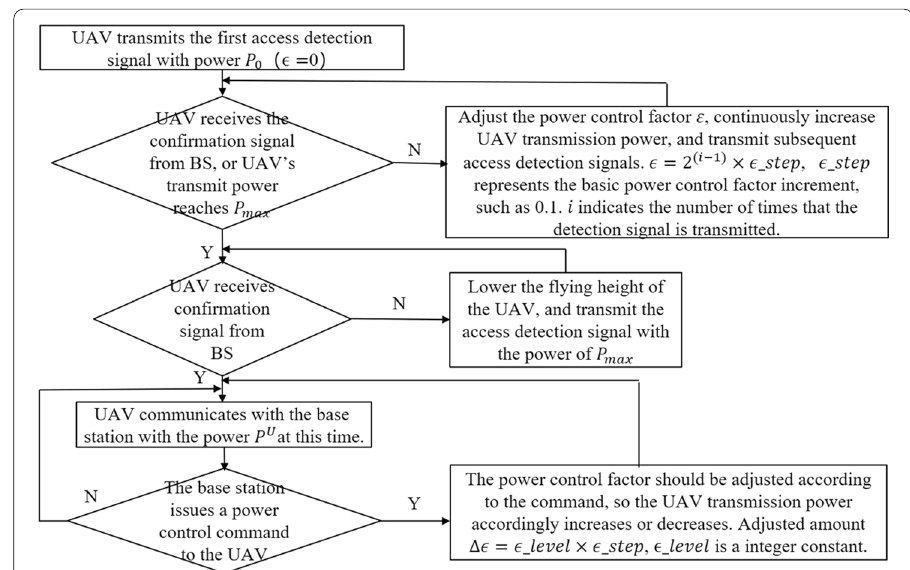
Fig.4 The whole power control procedure of the UAV